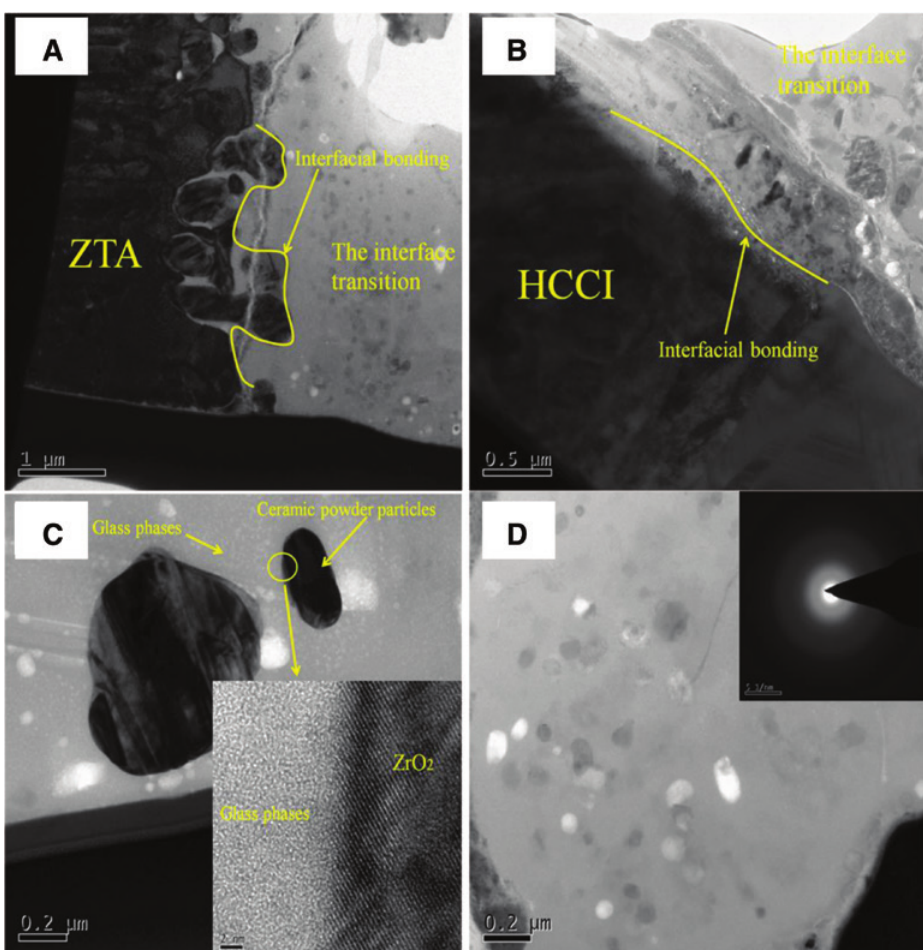
Figure 9: TEM images of the ITL: (A) ZTA combined with the ITL; (B) HCCI combined with the ITL; (C and D)